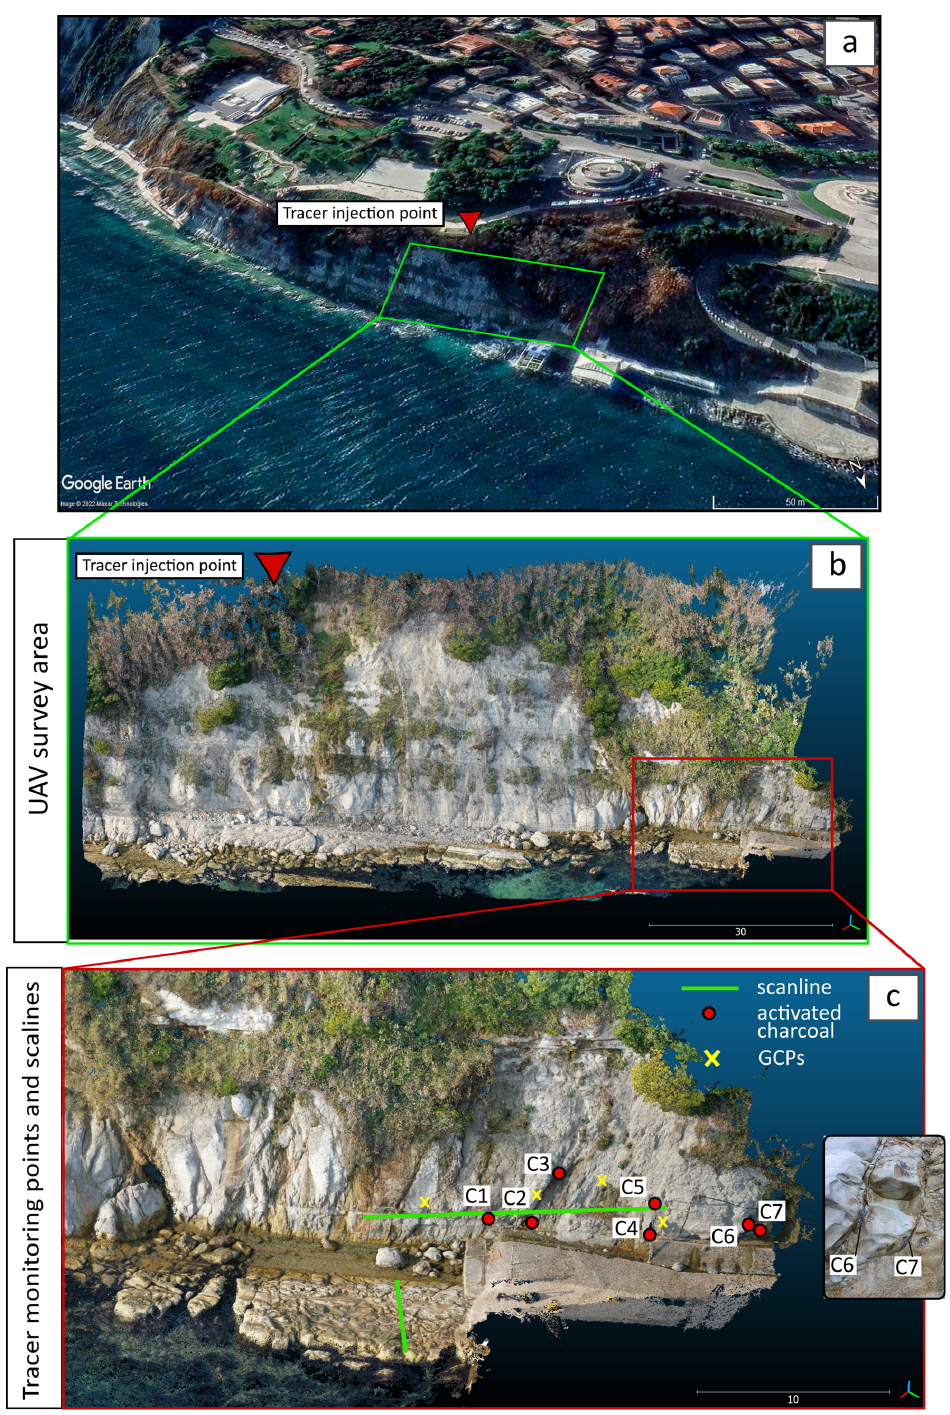
Figure 2. Overview of the monitoring strategy. ( a ) Position of the tracer injection point and the UAV survey; ( b ) UAV survey area; ( c ) position of the scanlines for the conventional geomechanical survey, with indication of the activated charcoal traps for tracer monitoring and some of the GCPs.